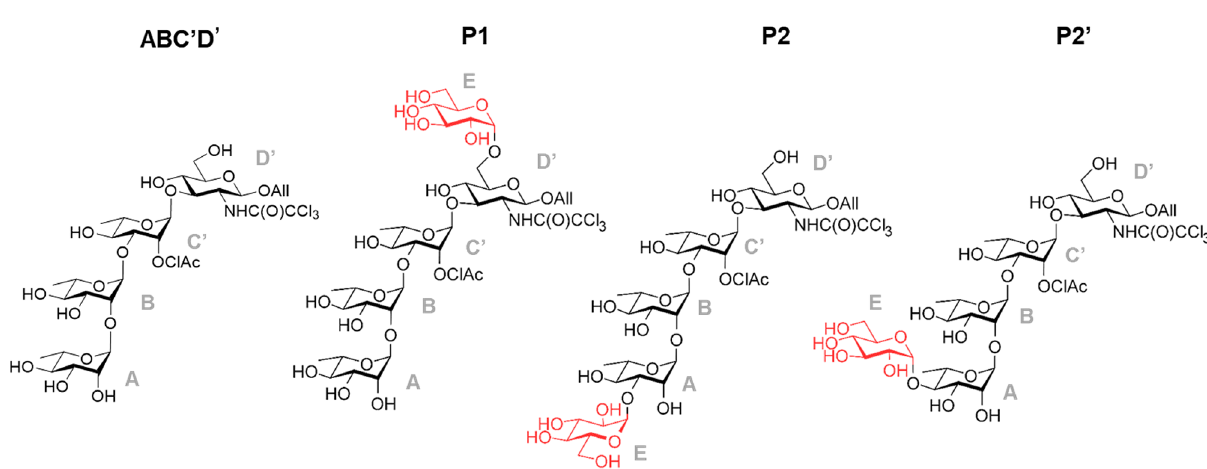
Figure 4. Structure of the tetrasaccharide acceptor ( ABC ′ D ′ ) and pentasaccharide products P1 (determined in Ref. 8 , P2 and P2 ′ ( E(1 → 3)ABC ′ D ′ and E(1 → 4)ABC ′ D ′ , respectively) characterized by NMR spectroscopy. In red is highlighted the glucosyl moiety ( E ). All allyl, ClAc chloroacetyl. Drawing of chemical structures done using CHEMDRAW P2 ′ isomer (Supplementary Fig. S4A). The E units belonging to P2 resonance was found by subtraction of P2 ′ and dechloroacetylated tetrasaccharide signals. All connectivities of the latter E units were found by DQF COSY spectrum (Supplementary Fig. S5). The assignment of the glucosylated position 3 A was derived from the HSQC spectrum. Only the resonance of 3 A from the non-superimposed tetrasaccharide peaks, was shifted, the 4 A and 4 B were superimposed in the tetrasaccharide spectrum. This observation suggested two assumptions; the glu- cosylation occurred on 3 A or on 2 A of the tetrasaccharide. It is known that glucosylation leads to slightly lower frequency shift of the adjacent resonance of the glucosylated position. However, no peak was observed in the anomeric region (Supplementary Fig. S4B), which confirmed that glucosylation occurs at OH- 3 A . The HMBC spectrum showed the cross-correlation peak of the E units and the assigned 3 A resonance.